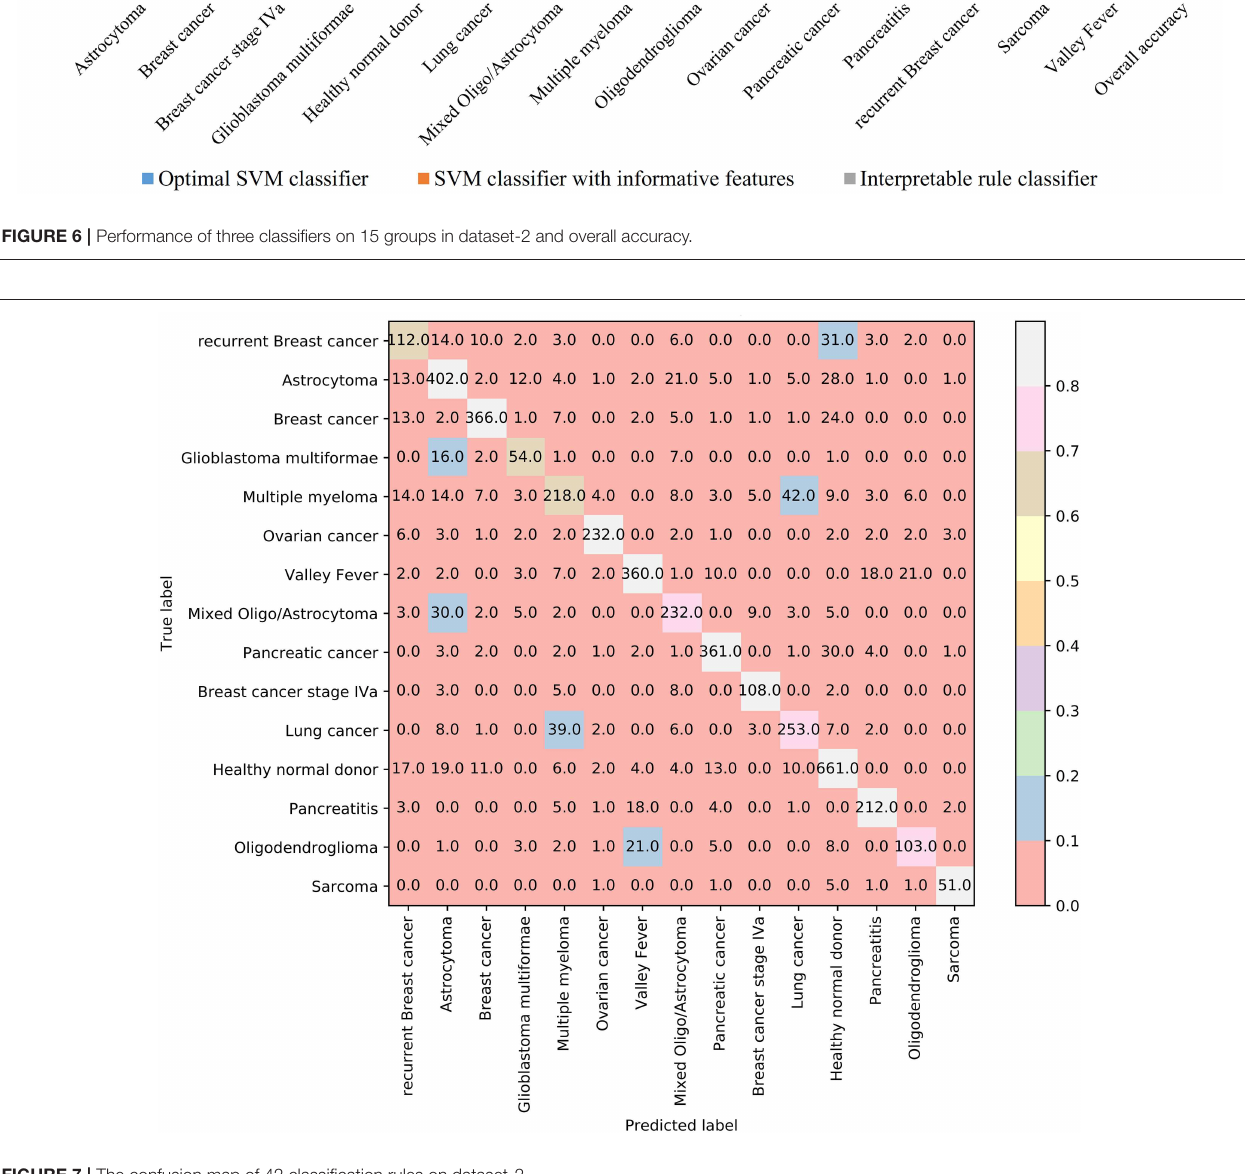
same computational approach, hoping to represent